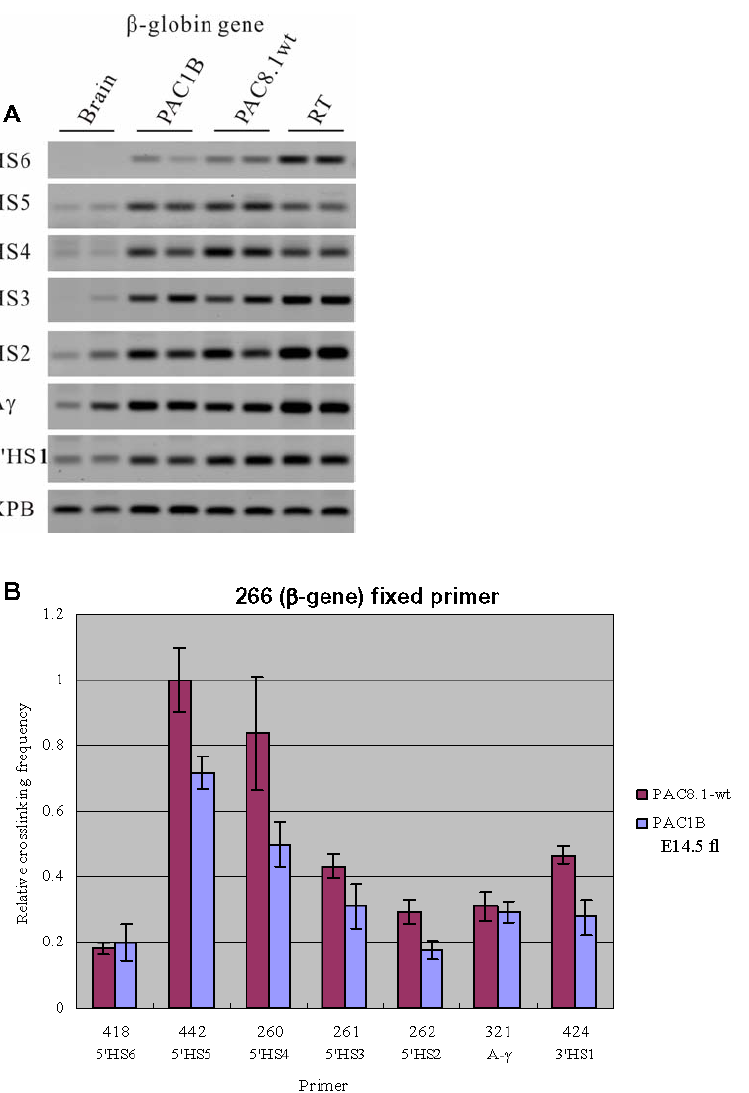
Figure 2. 3C analysis of the PAC1B transgene using a primer from the human b -globin gene in combination with primers from other parts of the locus. Fetal livers were collected from E14.5 embryos for this set of 3C experiments. (A) Representative examples of the PCR fragments resulting from the 3C experiments. WT: PAC8.1wt; RT: Random template control. (B) Histogram of the relative crosslinking efficiencies after quantitation and normalization. The histograms are the average of at least three separate experiments, with each PCR performed in